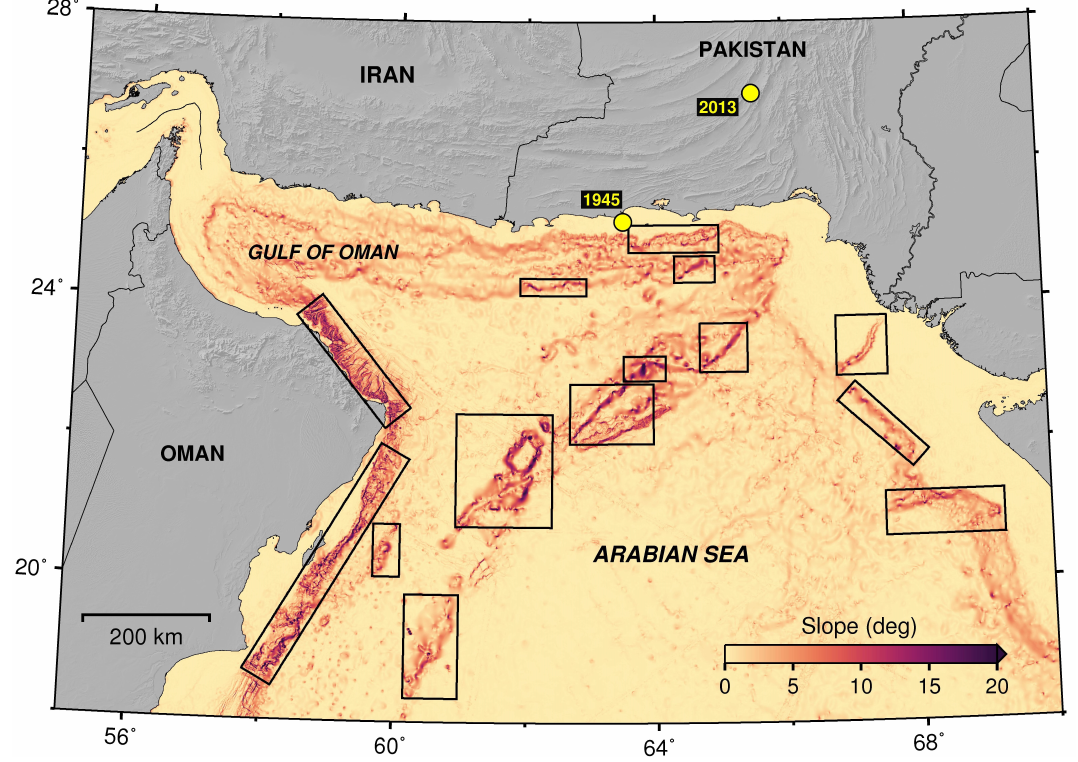
Figure 3. Slope gradient map of the Makran bathymetry and locations of areas prone to submarine landslides (solid black lines). Yellow circles show the locations of the 1945 and 2013 tsunamigenic